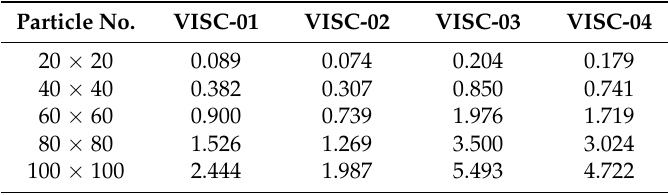
Table 3. Comparisons of CPU time with different particle numbers and viscosity calculation methods under the non-uniform particle distribution (unit: